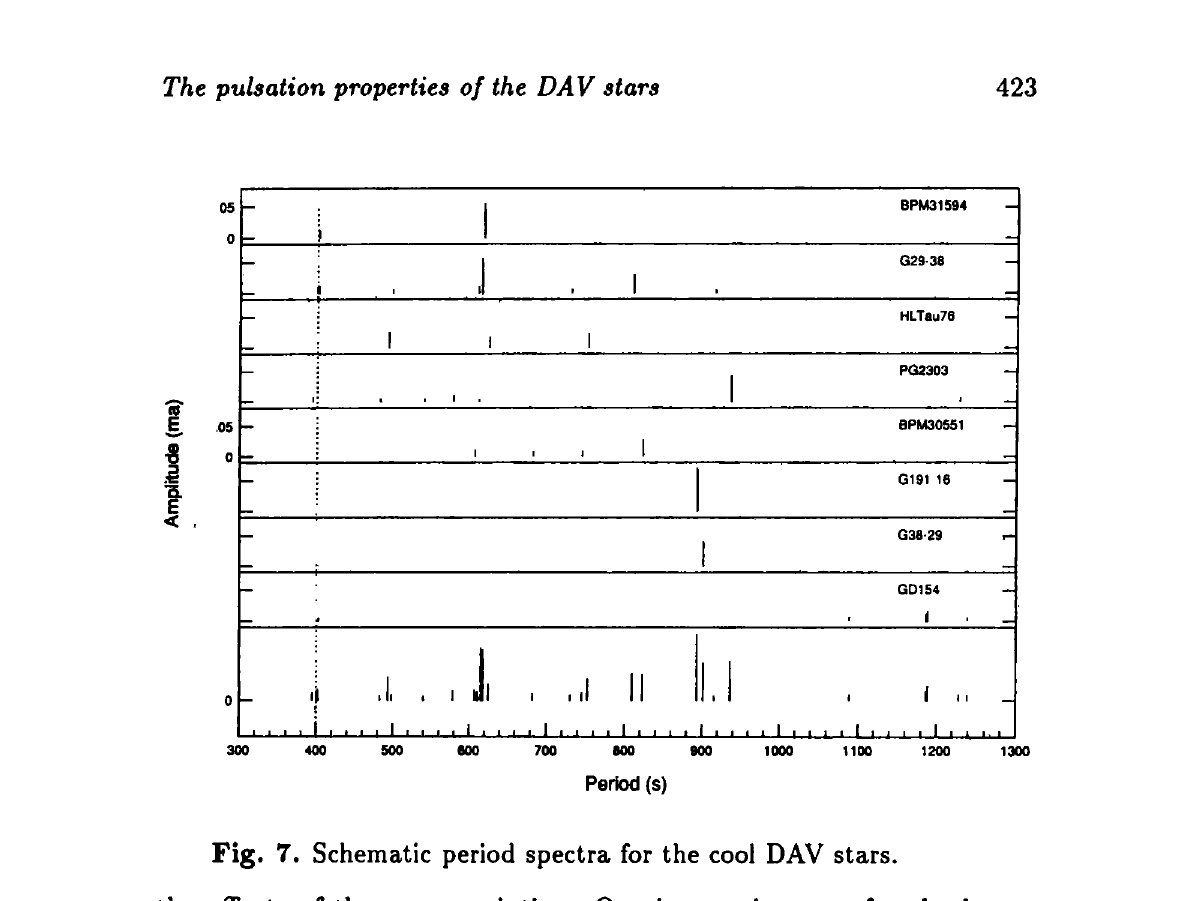
Fig. 7. Schematic period spectra for the cool DAV